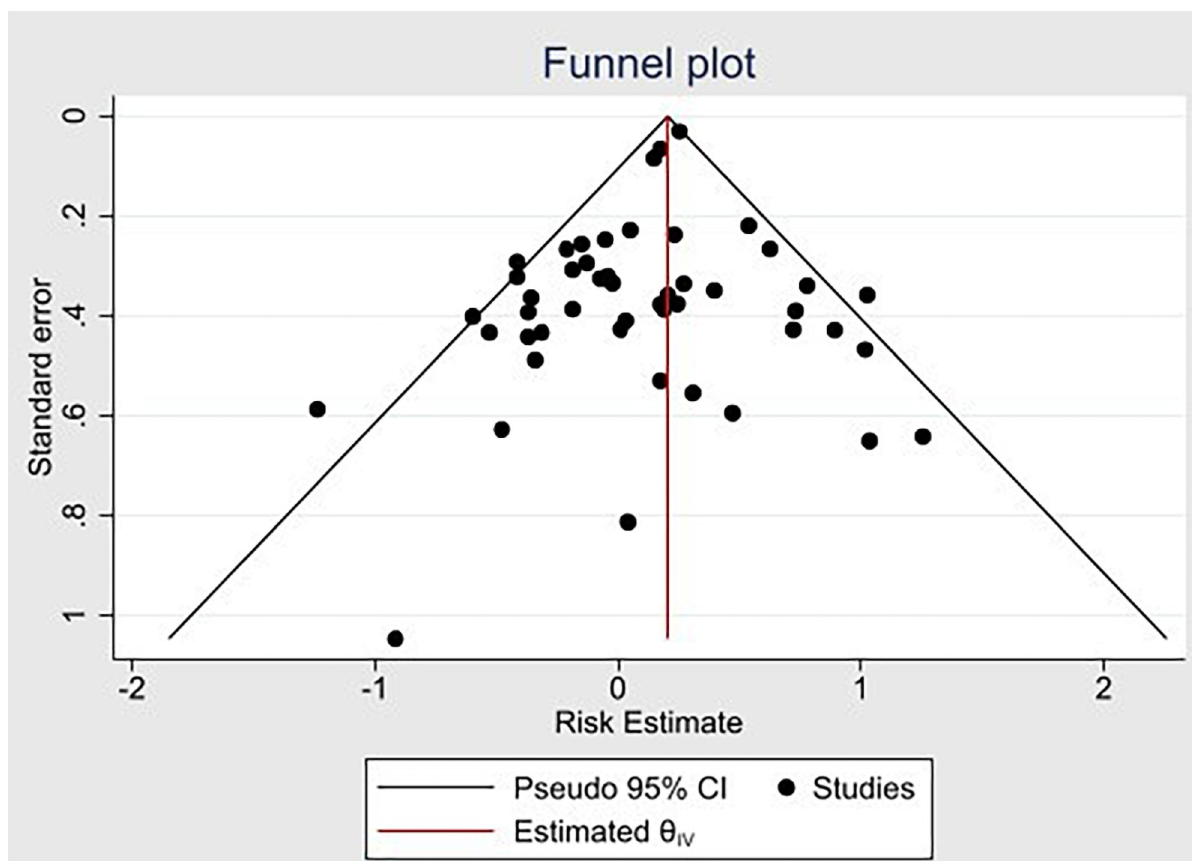
Fig 7. Funnel plot showing publication bias across all studies. CI, confidence interval. Estimated θ IV , Estimated effect-size line.